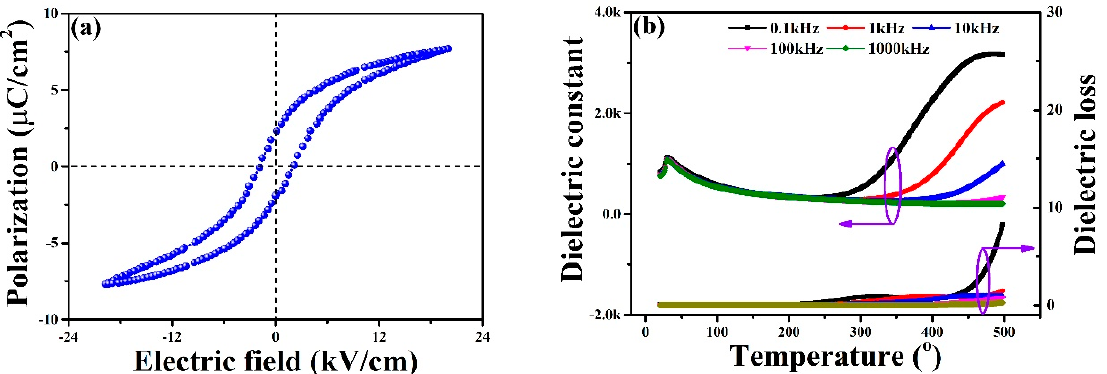
Figure 3. ( a ) Ferroelectric hysteresis loop of BST thin films. ( b ) Temperature-dependent dielectric constant and loss of the BST under diverse frequencies.